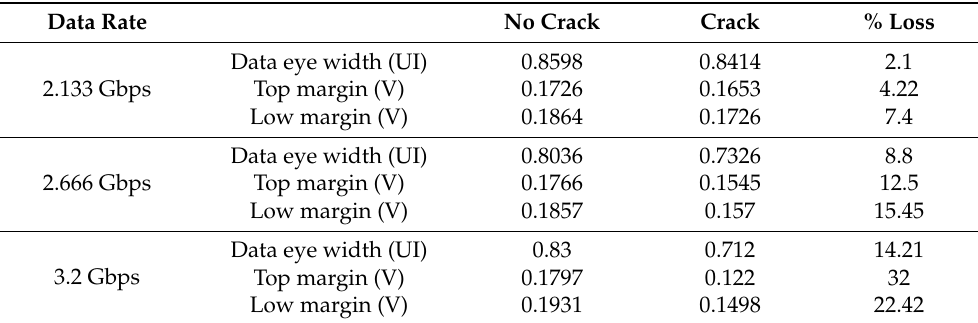
Table 2. Data eye width and voltage margin loss due to crack for different data rates.